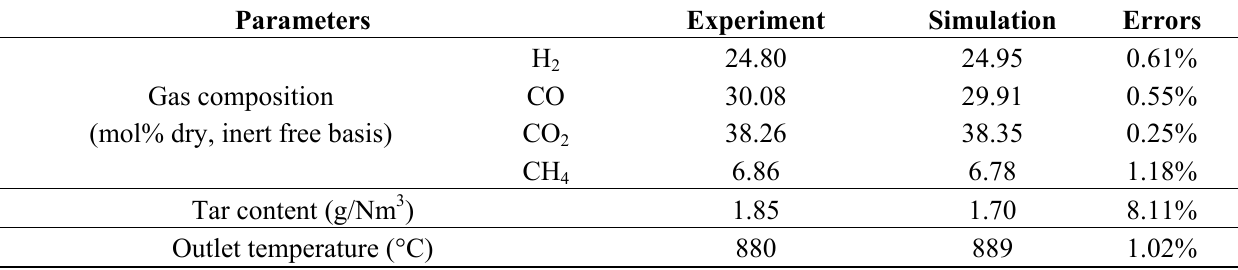
Table 4. Comparison between experimental and simulated